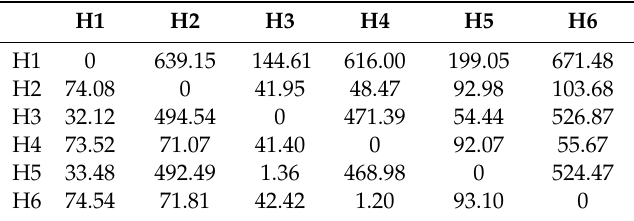
Table 2. The MFPTs between the intermediate states of holo-HFABP (unit: µ